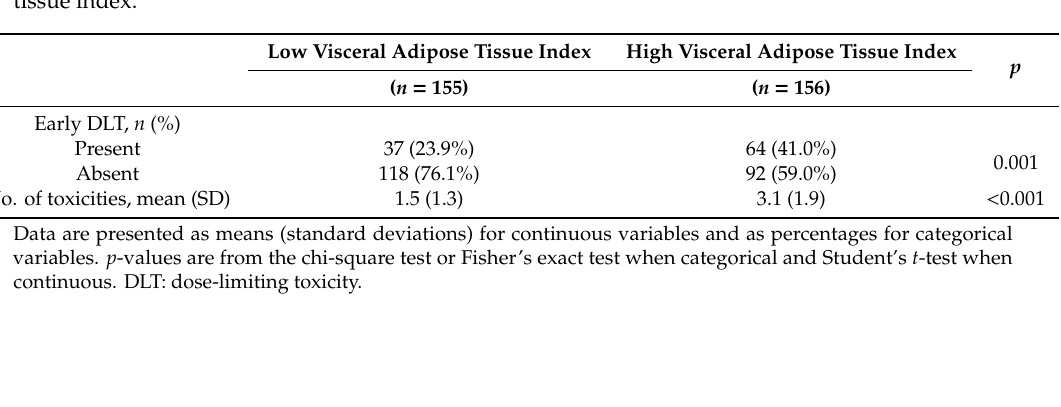
Table 3. Comparison of the sunitinib toxicities between patients with a high / low visceral adipose tissue